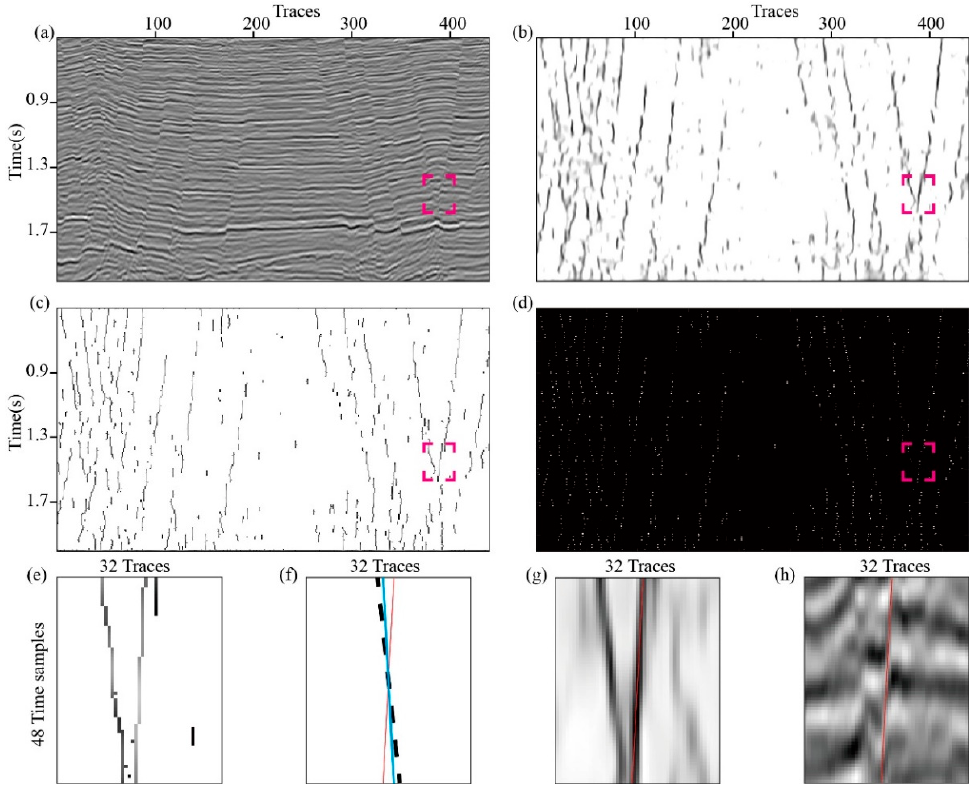
Figure 5. The workflow of generating real fault samples and corresponding labels. We first calculate the fault enhancement attribute ( b ) on the seismic images ( a ). We then apply non-maximum sup- pression on the fault enhancement attribute to obtain the thinned fault image ( c ) and get the seed points ( d ). Centered on the seed points, the windowed thinned fault images ( e ) are extracted. The fault orientations are estimated based on the windowed thinned fault images and the labels can be obtained ( f ). The fault label is overlaid with the fault enhancement attribute ( g ) and seismic image ( h